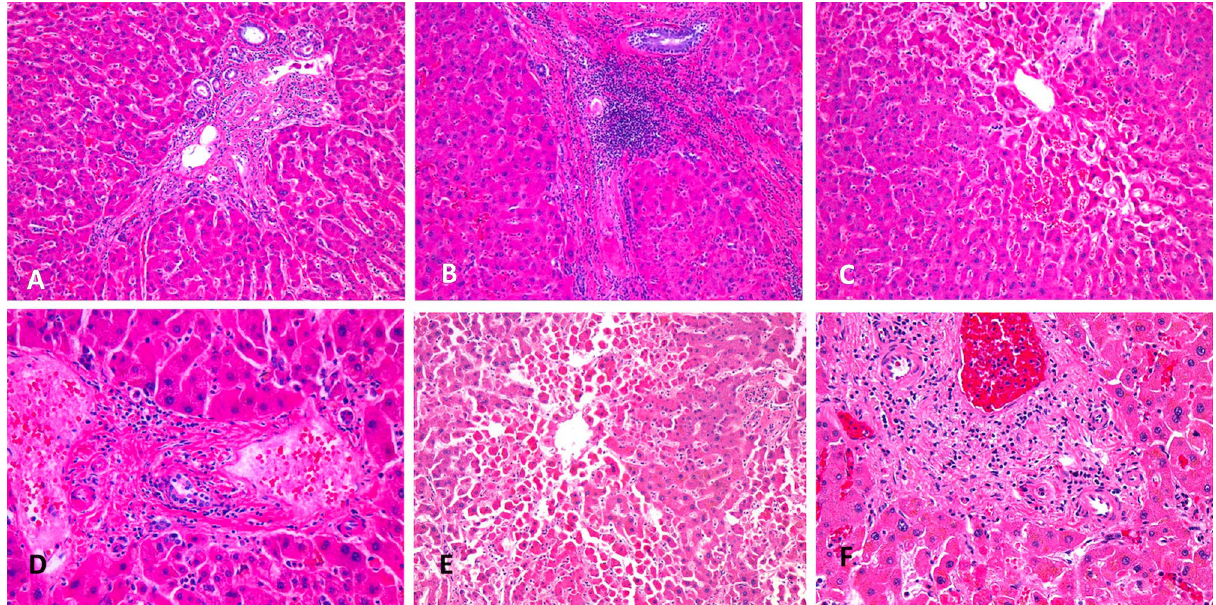
Figure 2. Postmortem liver findings in COVID-19. ( A ), ( B ) and ( C ) from patient 5, show minimal ( A ) to moderate ( B ) portal lymphocytic infiltrate and central vein outflow obstruction injury ( C ); ( D ) from patient 3, shows minimal portal lymphocytic infiltrate and fibrin thrombi; ( E ) and ( F ) from patient 7, show extensive central vein outflow obstruction associated with centrilobular necrosis ( E ) and mild portal lymphocytic infiltrate ( F